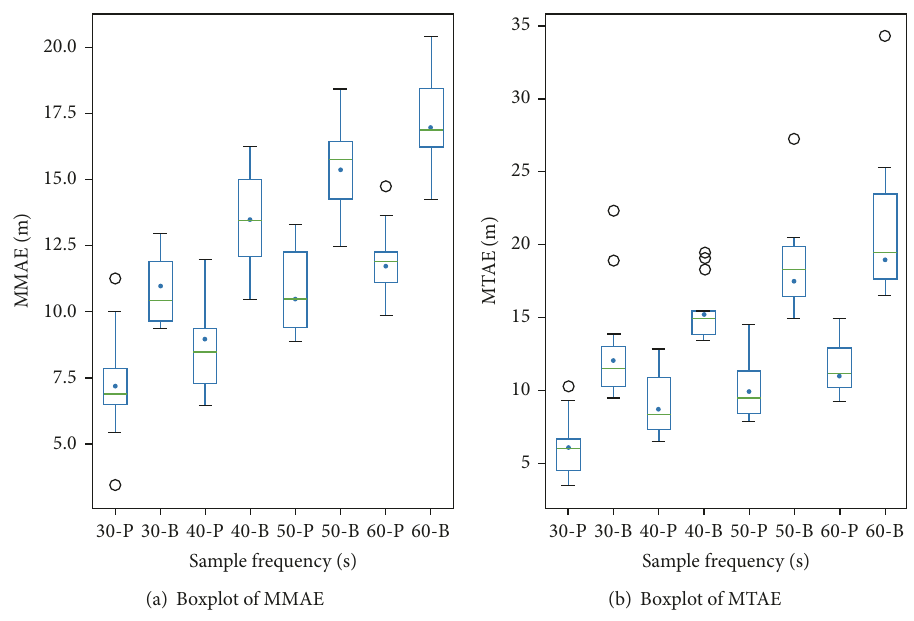
Figure 12: Sensitivity analysis with different sample